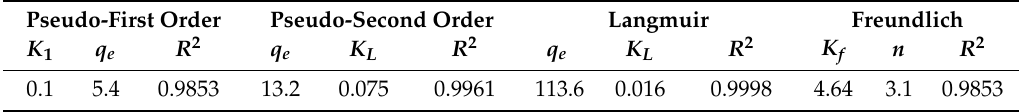
Table 1. Kinetic models and isotherms parameters for Cd 2 + adsorption onto PVA-CDs. Pseudo-First Order